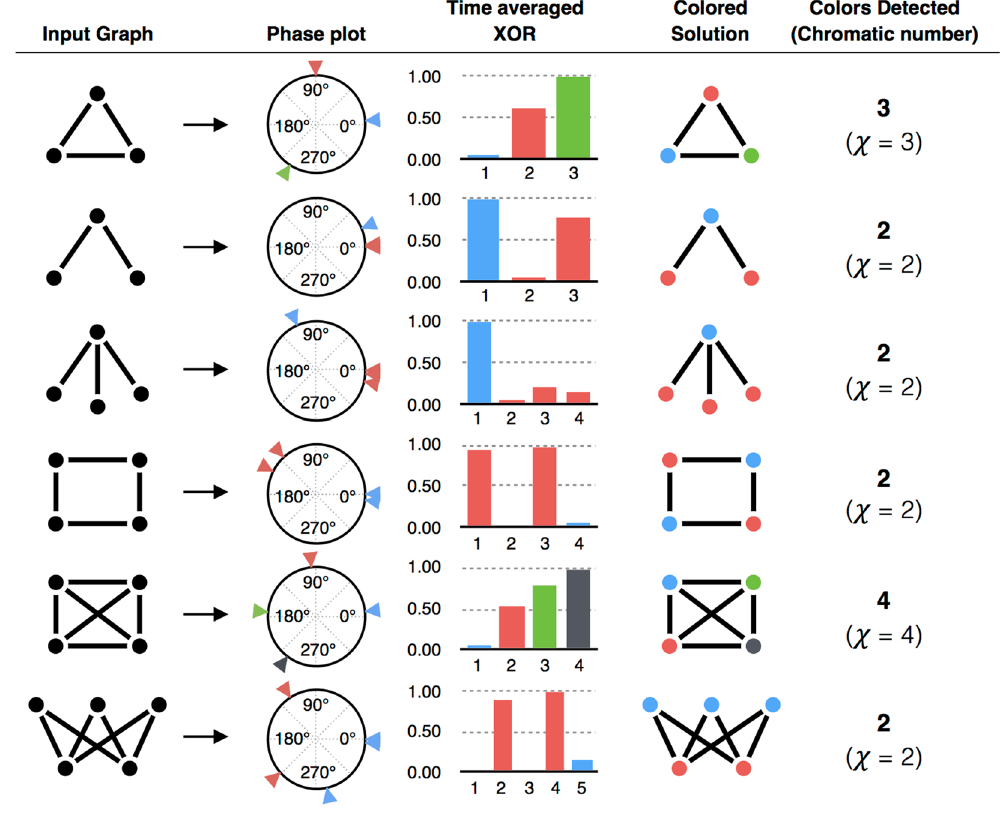
Figure 4. Experimental results of graph coloring using coupled VO 2 based oscillators. Various graph configurations, and their experimentally obtained solutions (PFD outputs and XOR values) using the coupled relaxation oscillator system. After mapping the graphs onto the coupled oscillator hardware, the steady state order of phases of oscillators is used as a color-sorting and a color assignment is